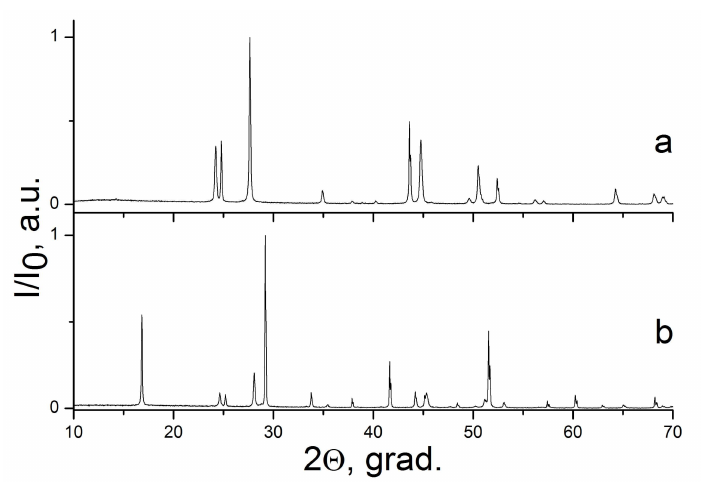
Figure 5. X-ray patterns of specimens in the NaF–LaF 3 and NaF–CeF 3 systems: Sample 6 ( a ), LaF 3 phase; and Sample 7 ( b ), NaCeF 4 + CeF 3 phases.